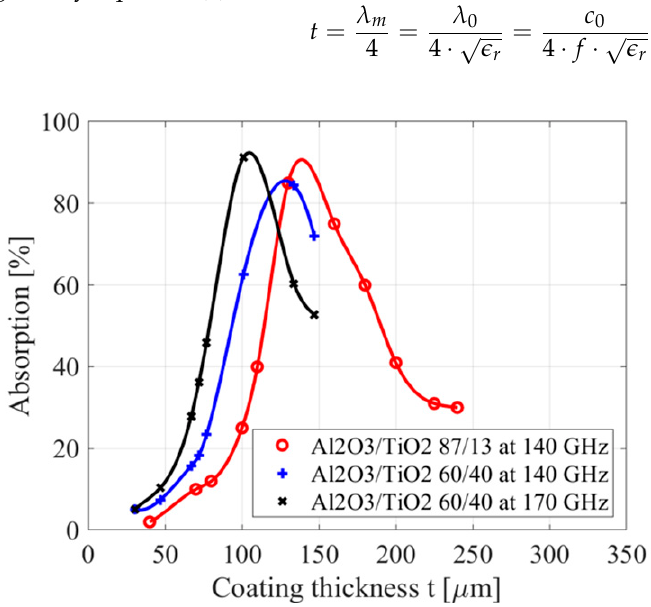
Figure 11. Comparison of the absorption measurements of Al 2 O 3 /TiO 2 87/13 at 140 GHz (red curve) [4] and Al 2 O 3 /TiO 2 60/40 at 140 GHz (blue curve) and at 170 GHz (black curve).